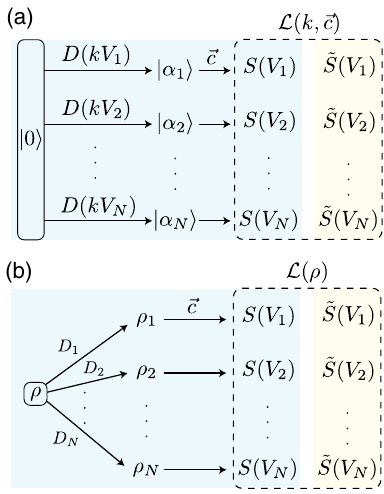
FIG. 9. Schematic of pulse calibration and tomography. (a) Pulse calibration is done by minimizing the loss function L ð k; ⃗ c Þ , where k is the scaling factor that converts the voltage of the pulse into the amplitude of displacement in phase space and ⃗ c are the coefficients for the linear transformation that maps a quantum state into its transient PSD. (b) The loss function for state tomography contains the contributions from the distance between measured and predicted transient PSDs for an unknown state ˆ ρ after each